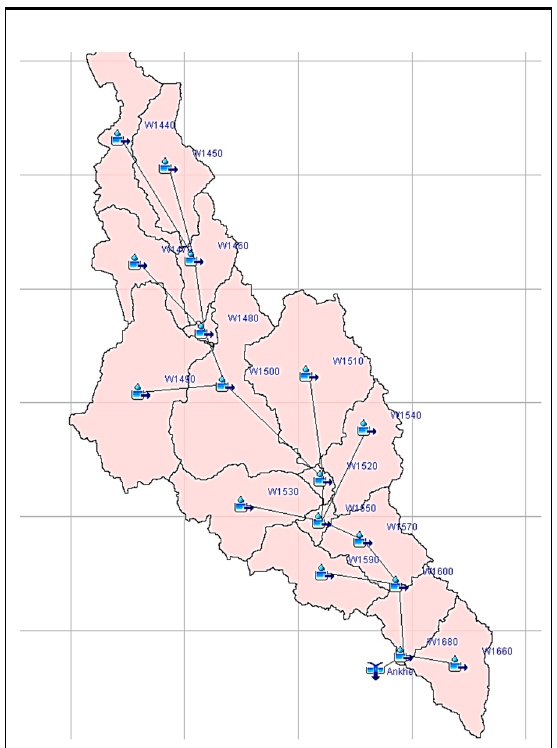
Figure 2. Catchment delineation and stream network.